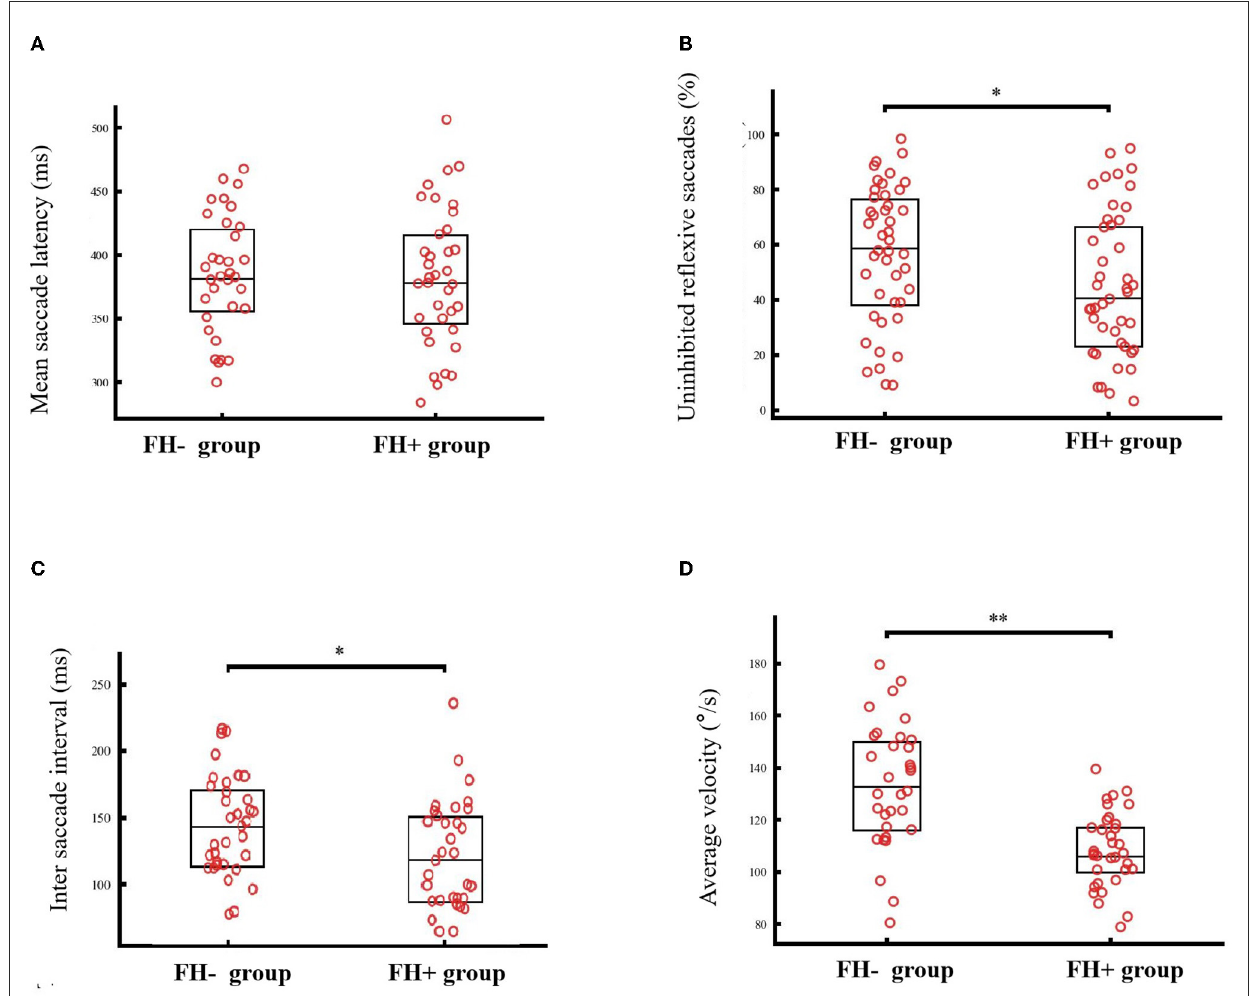
FIGURE1 The saccadic performance of individuals with (FH + ) or without family history (FH-). No group difference was observed regarding the mean saccade latency [380.8 ± 53.8ms vs. 383.5 ± 45.9ms, T 67 = 0.227 , p = 0.82, (A) ], but FH + group showed relatively fewer uninhibited reflexive saccades [44.7 vs. 56.2%, p = 0.037, (B) ], shorter saccade interval between uninhibited reflexive saccade and saccade toward the target [121.6ms vs. 143.9ms, p = 0.023, (C) ]. While, the FH + group displayed relatively lower average velocity than the FH- group [107.9 ◦ /s vs. 132.9 ◦ /s, p < 0.001 (D) ]. * p < 0.05, ** p <